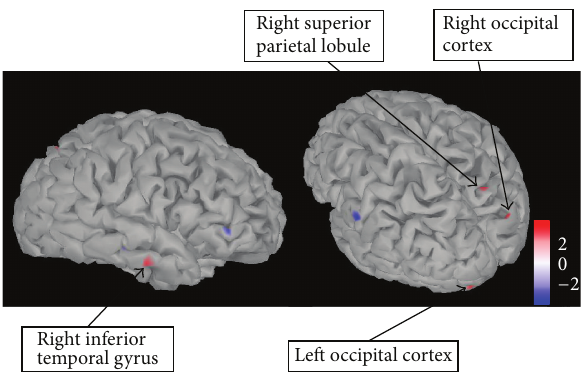
Figure 7: Regions showing significantly higher activation in the AN-R compared to AN-R group at 320 ms after stimulus. Regions showing significantly higher activation in a 𝑡 -test comparing the AN-R and AN-C group (shown in red) at 320 ms after stimulus (all food pictures versus baseline). Regions were identified by eye and are uncorrected for multiple comparisons ( 𝑝 = 0.005 ). Scale shown represents the 𝑡 -value. AN-R: recovered Anorexia Nervosa group, AN-C: current Anorexia Nervosa